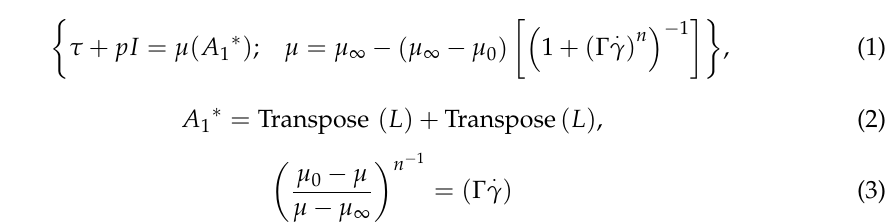
Figure 1. Physical behavior of fluid moving over cylindrical geometry. Cauchy stress tensor for the mathematical model of Carreau fluid and its related mathematical expressions.